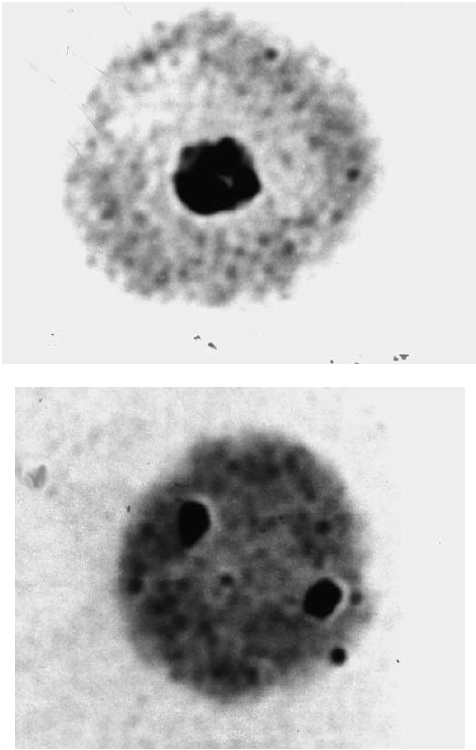
Fig. 1. AgNOR stained CLL lymphocytes (100 × objective magnifi- cation). On the top lymphocyte with one cluster, on the bottom lym- phocyte with 2 dots. variate Cox model (Exp( B ) = 0 . 9373; CI 95%